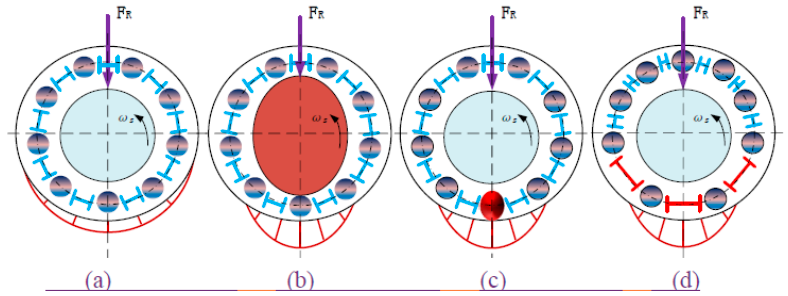
Figure 5 . Dynamic force waveforms and spectrum for error-free cases.